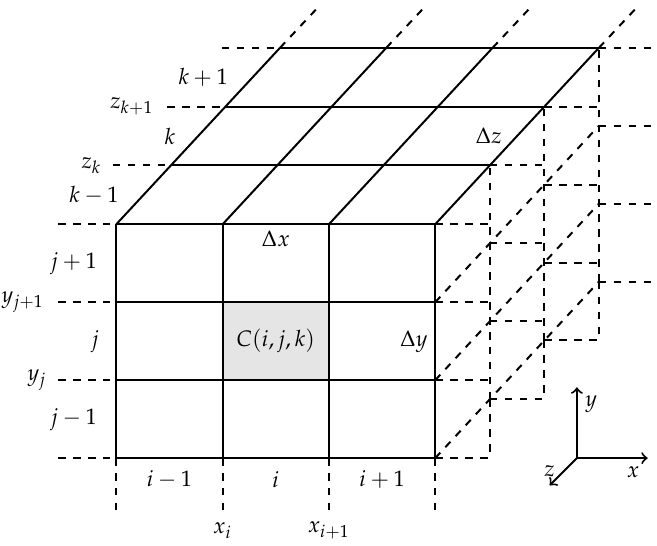
Figure 2. Representation of the 3D matrix of